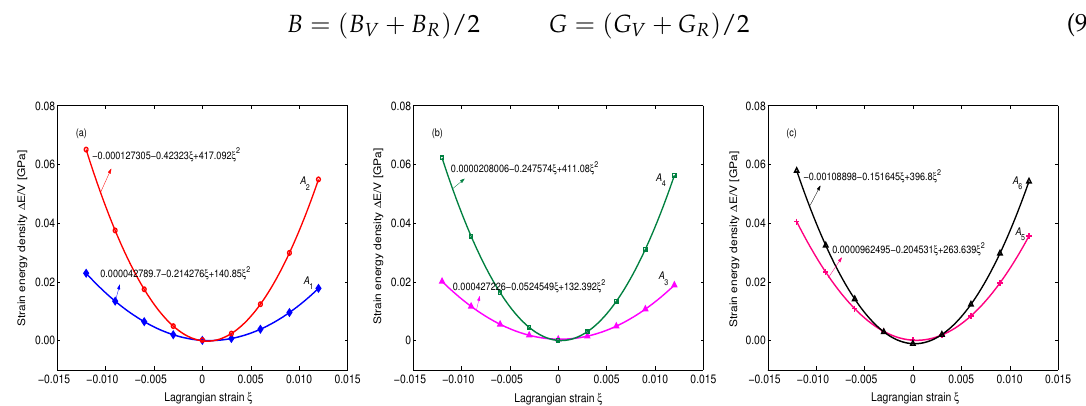
Figure 2. The strain-energy density relations of YNi 2 B 2 C at 0 GPa. The discrete points indicate the values from the first principles calculations and the solid curves represent the results obtained from the second-order polynomial